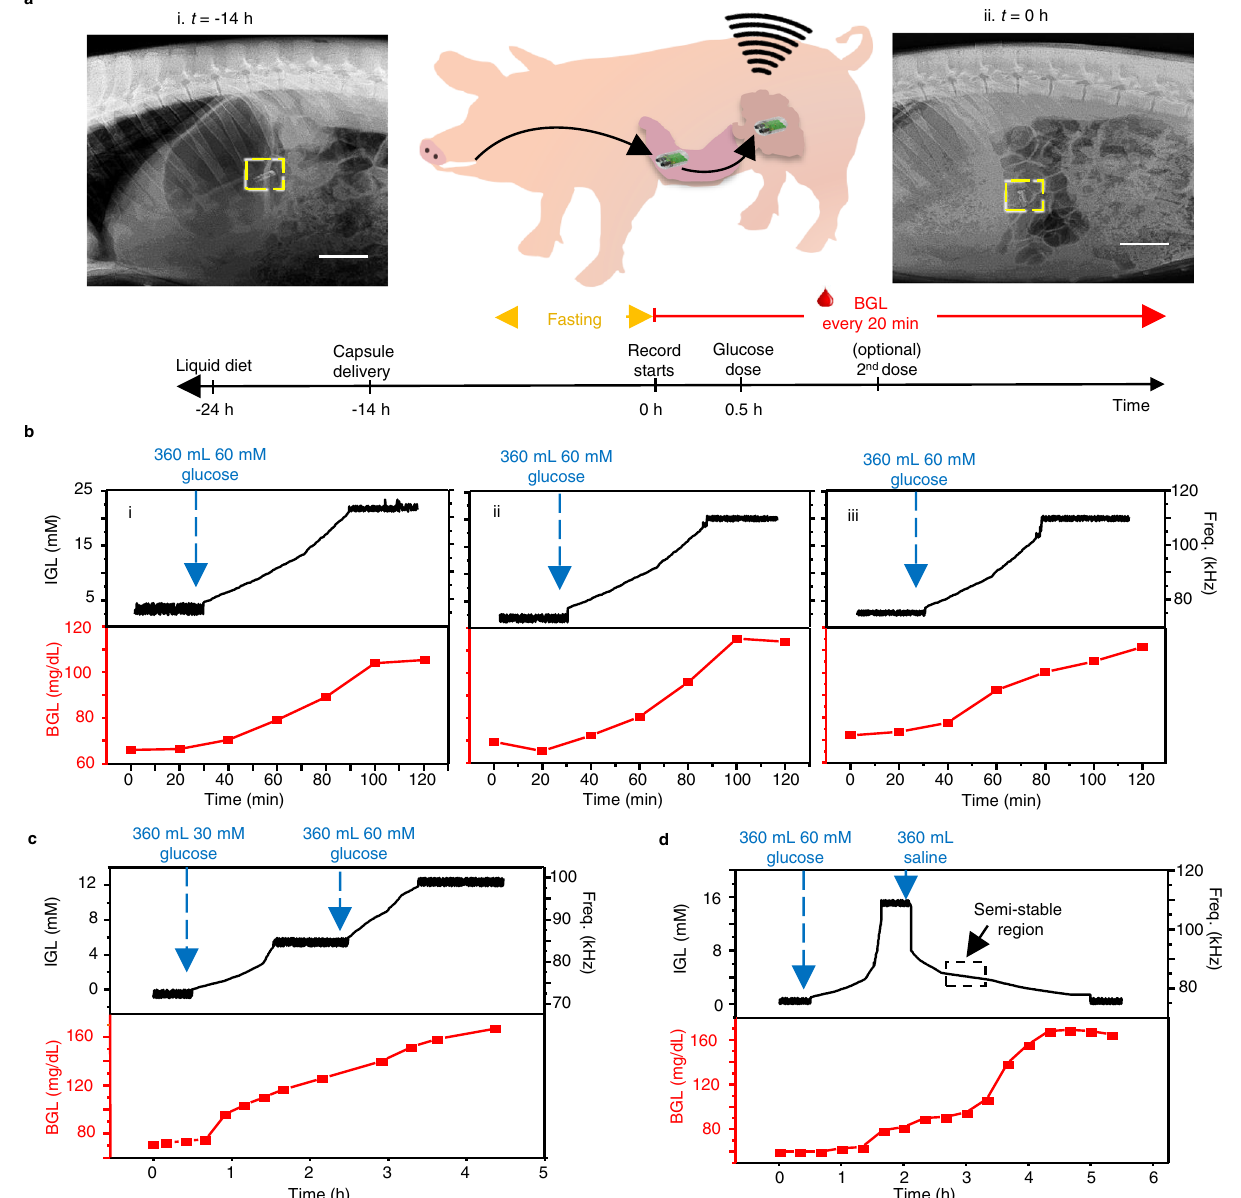
Fig.4|Capsuleinsituperformanceinaporcinemodel.a X-raysimagesofthepig afteroraldeliveryofthecapsule(top)at t = − 14h(i)and t =0h(ii),andthetimeline of the experiment protocol (bottom). Scale bar, 5cm. b IGL and BGL monitoring after delivering a 360mL of 60mM glucose saline dosage ( t =30min) in 3 inde- pendent in situ experiments (i – iii). c In situ experiment tracking the IGL and BGL